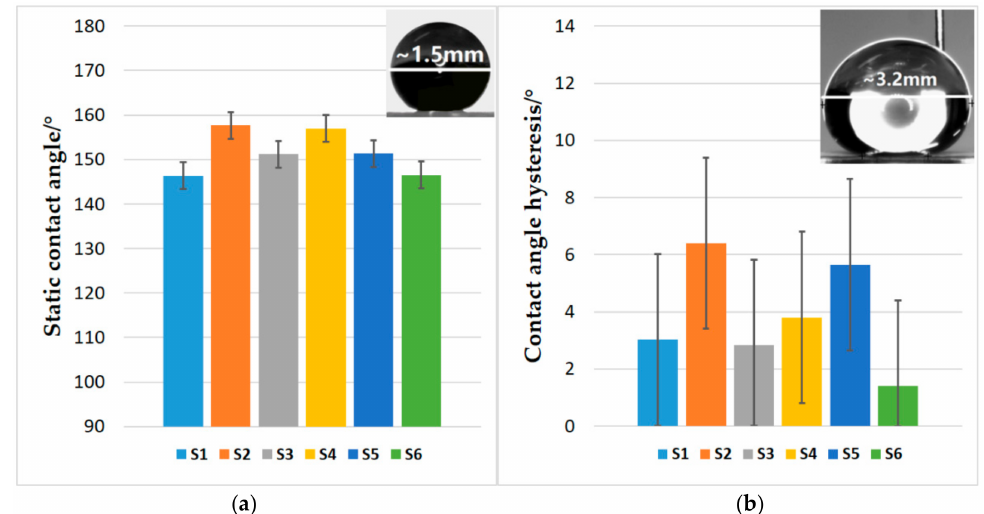
Figure 7. The apparent quasi-static contact angles ( a ), and contact angle hysteresis ( b ) of six different Teflon FEP surfaces with high-aspect-ratio nanowire structures made with the same AAO molds of SP-01. The inset in each figure shows an exemplary image of a sessile droplet of water used for the contact angle